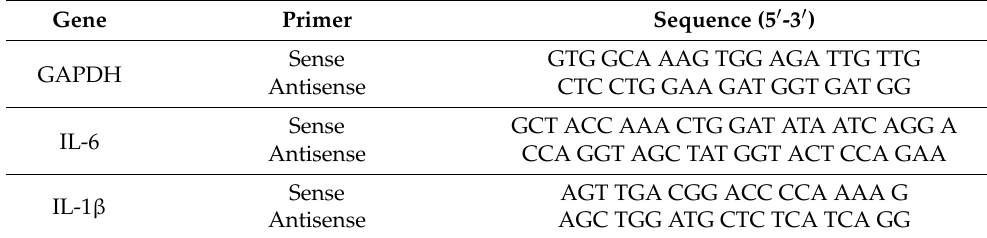
Table 1. List of specific primers for